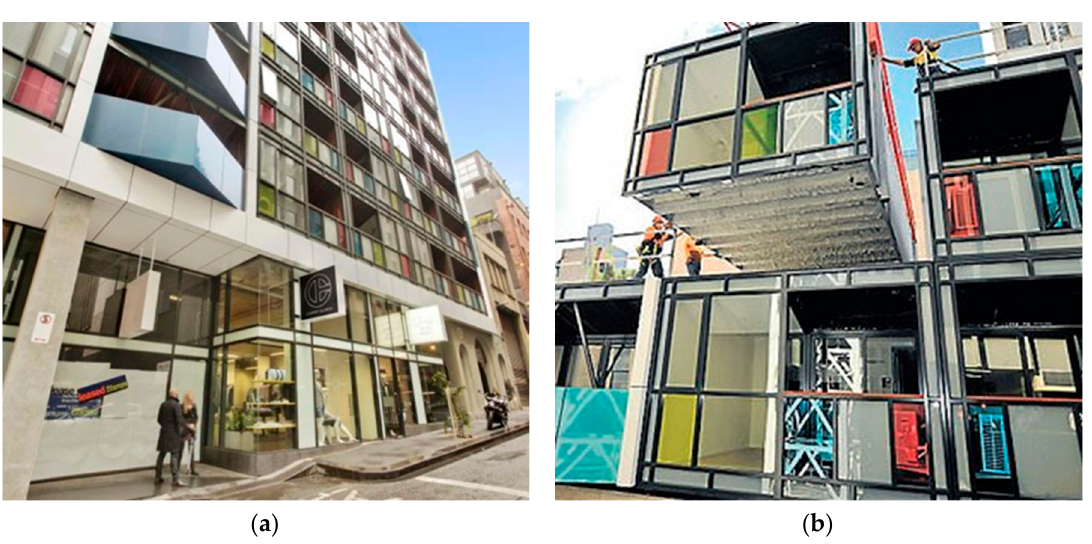
Figure 1. An image from the modular building ‘Little Hero’: ( a ) After being built and occupied; ( b ) During its on-site assembly (Images by Tuan Ngo).